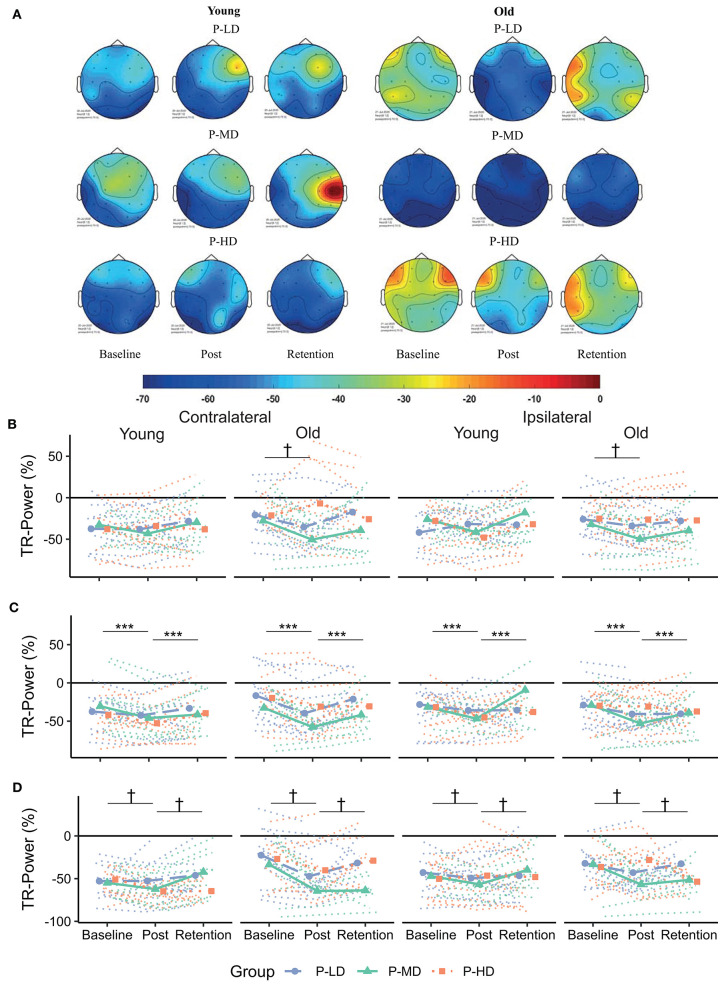
(A) Topographical plots showing the distribution of alpha TR-Power over the ROIs for the different age and practice groups. Cooler colors represent lower TR-Power (i.e., higher activity). Black dots represent the electrodes used to define the ROIs. (B–D) Change in TR-Power over time for the frontal (B), motor (C) and parietal (D) cortex. Dotted lines represent individual trajectories. Overall, alpha power was more lateralized (i.e., more negative) contralateral to the moving hand for younger compared to older adults. Over the frontal and parietal cortices, TR-Power decreased from baseline to the post-test. This decrease was greatest for older adults practicing at a low or medium difficulty level. P-LD, Practice with Low Difficulty (blue dots); P-MD, Practice with Medium Difficulty (green triangles); P-HD, Practice with High Difficulty (orange squares). ***Main effect of time at p < 0.001; †Time*Age*Practice group interaction at p < 0.05.